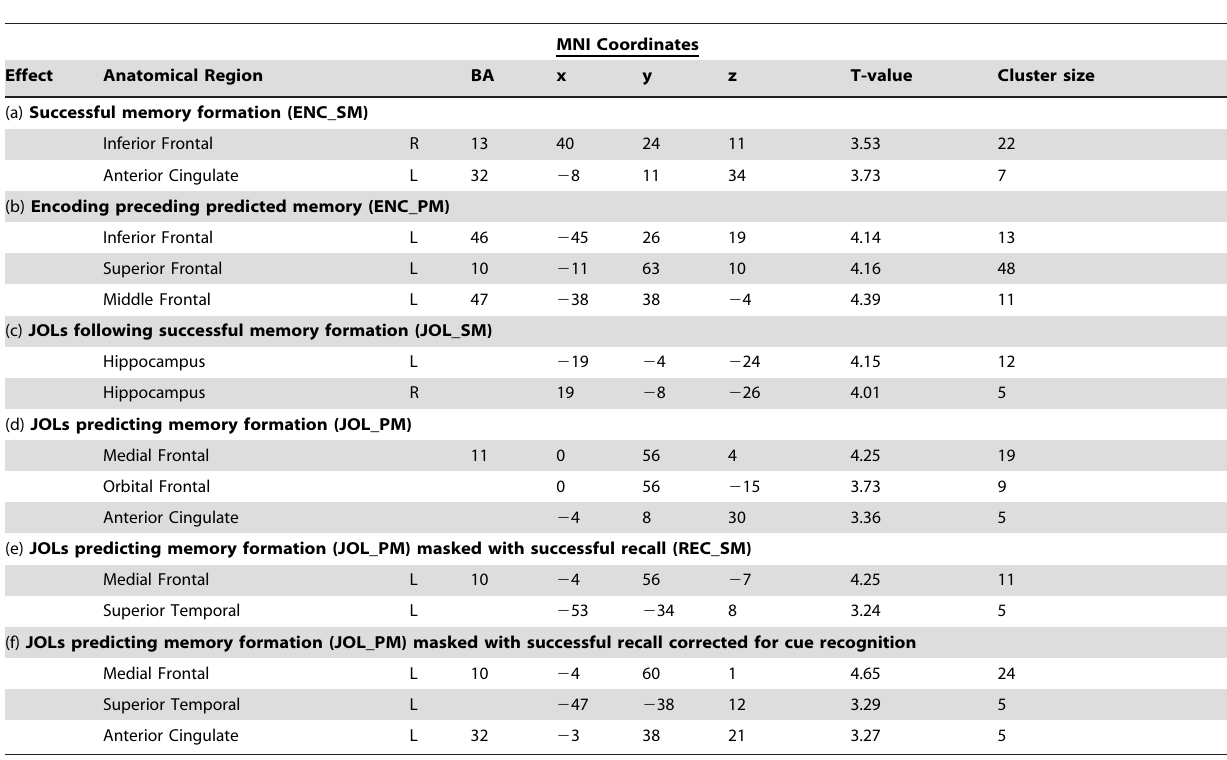
Table 1. Brain areas associated with (a) successful memory formation and (b) encoding preceding predicted memory, (c)